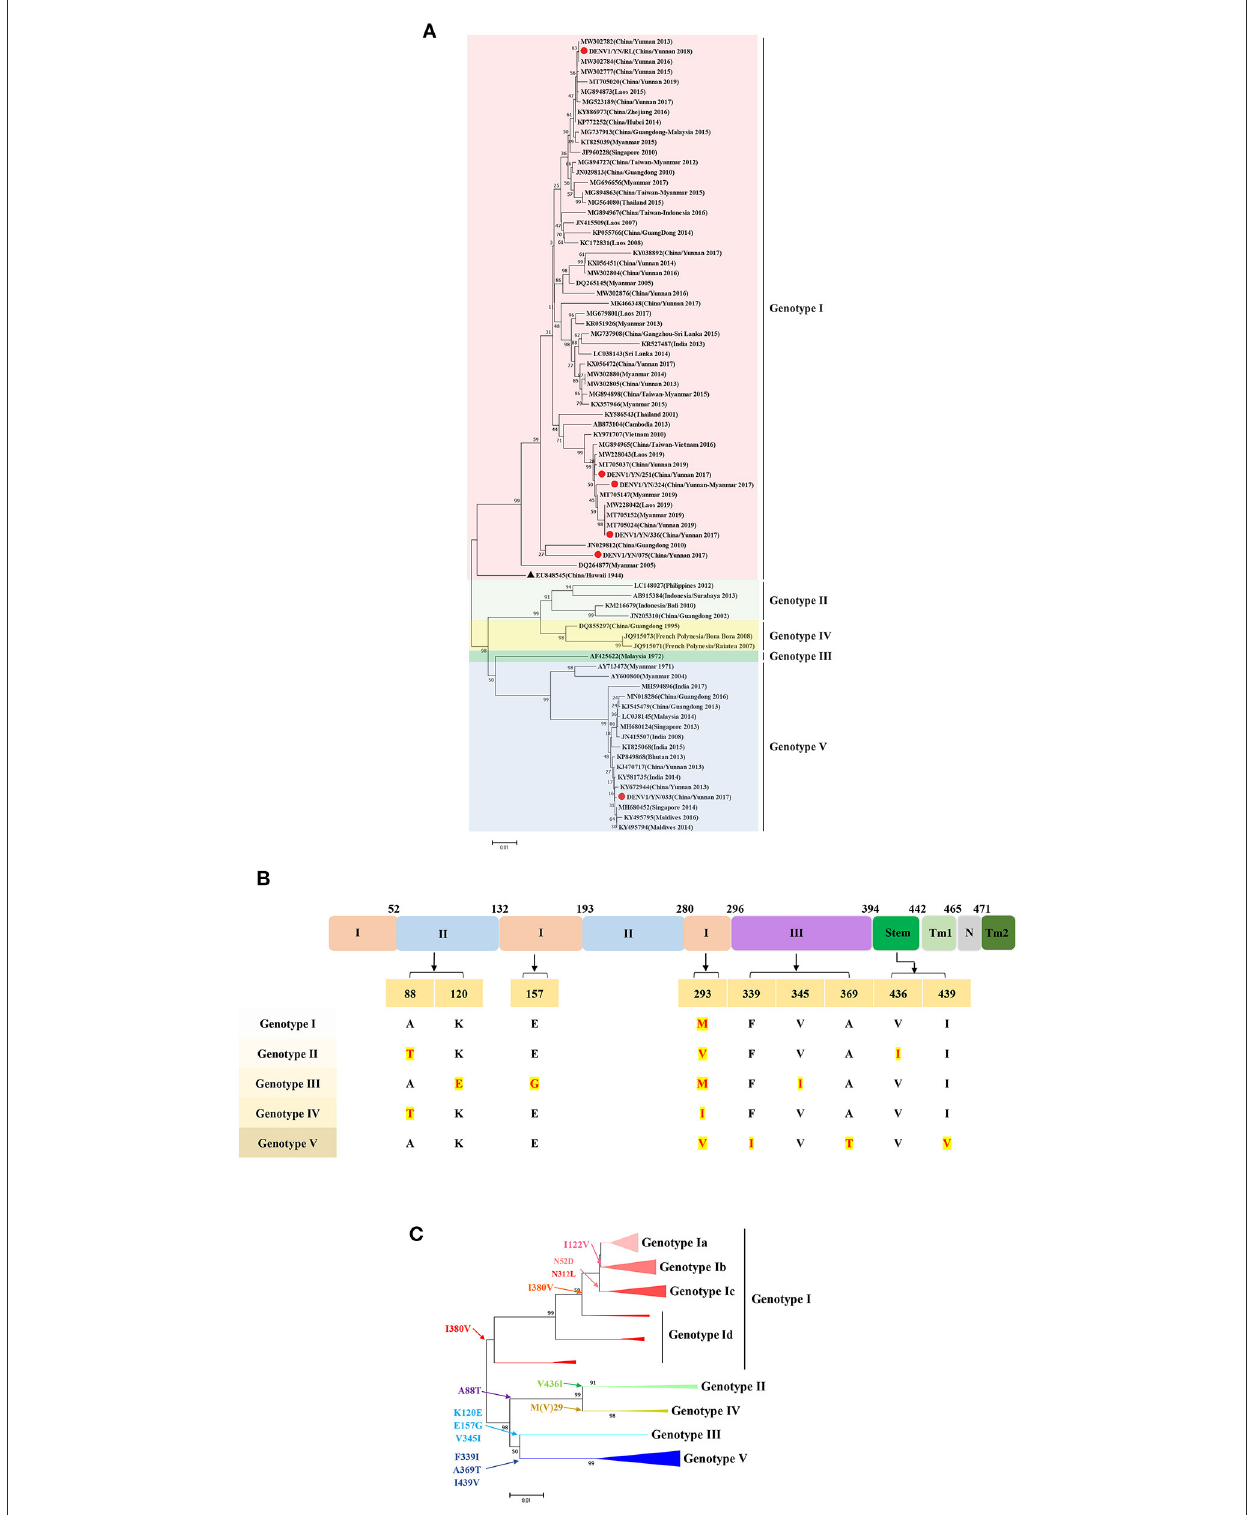
FIGURE3 (A) Phylogenetic tree of DENV-1 epidemic strains in Yunnan, China. The maximum likelihood (ML) trees were built using 1,000 bootstrap replicates. The red circles indicate the strains detected in this study. (B) The characteristics of AA variations among different genotypes of DENV2. (C) Relationship between the evolutionary tree branching and AA mutations in genotype I of